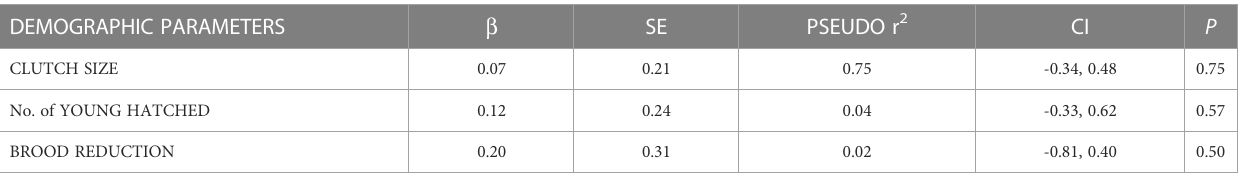
TABLE 2 Results for GLMs used to compare demographic parameters between treatment types during the 2021 osprey breeding season in the lower Chesapeake Bay, VA, USA. DEMOGRAPHIC PARAMETERS